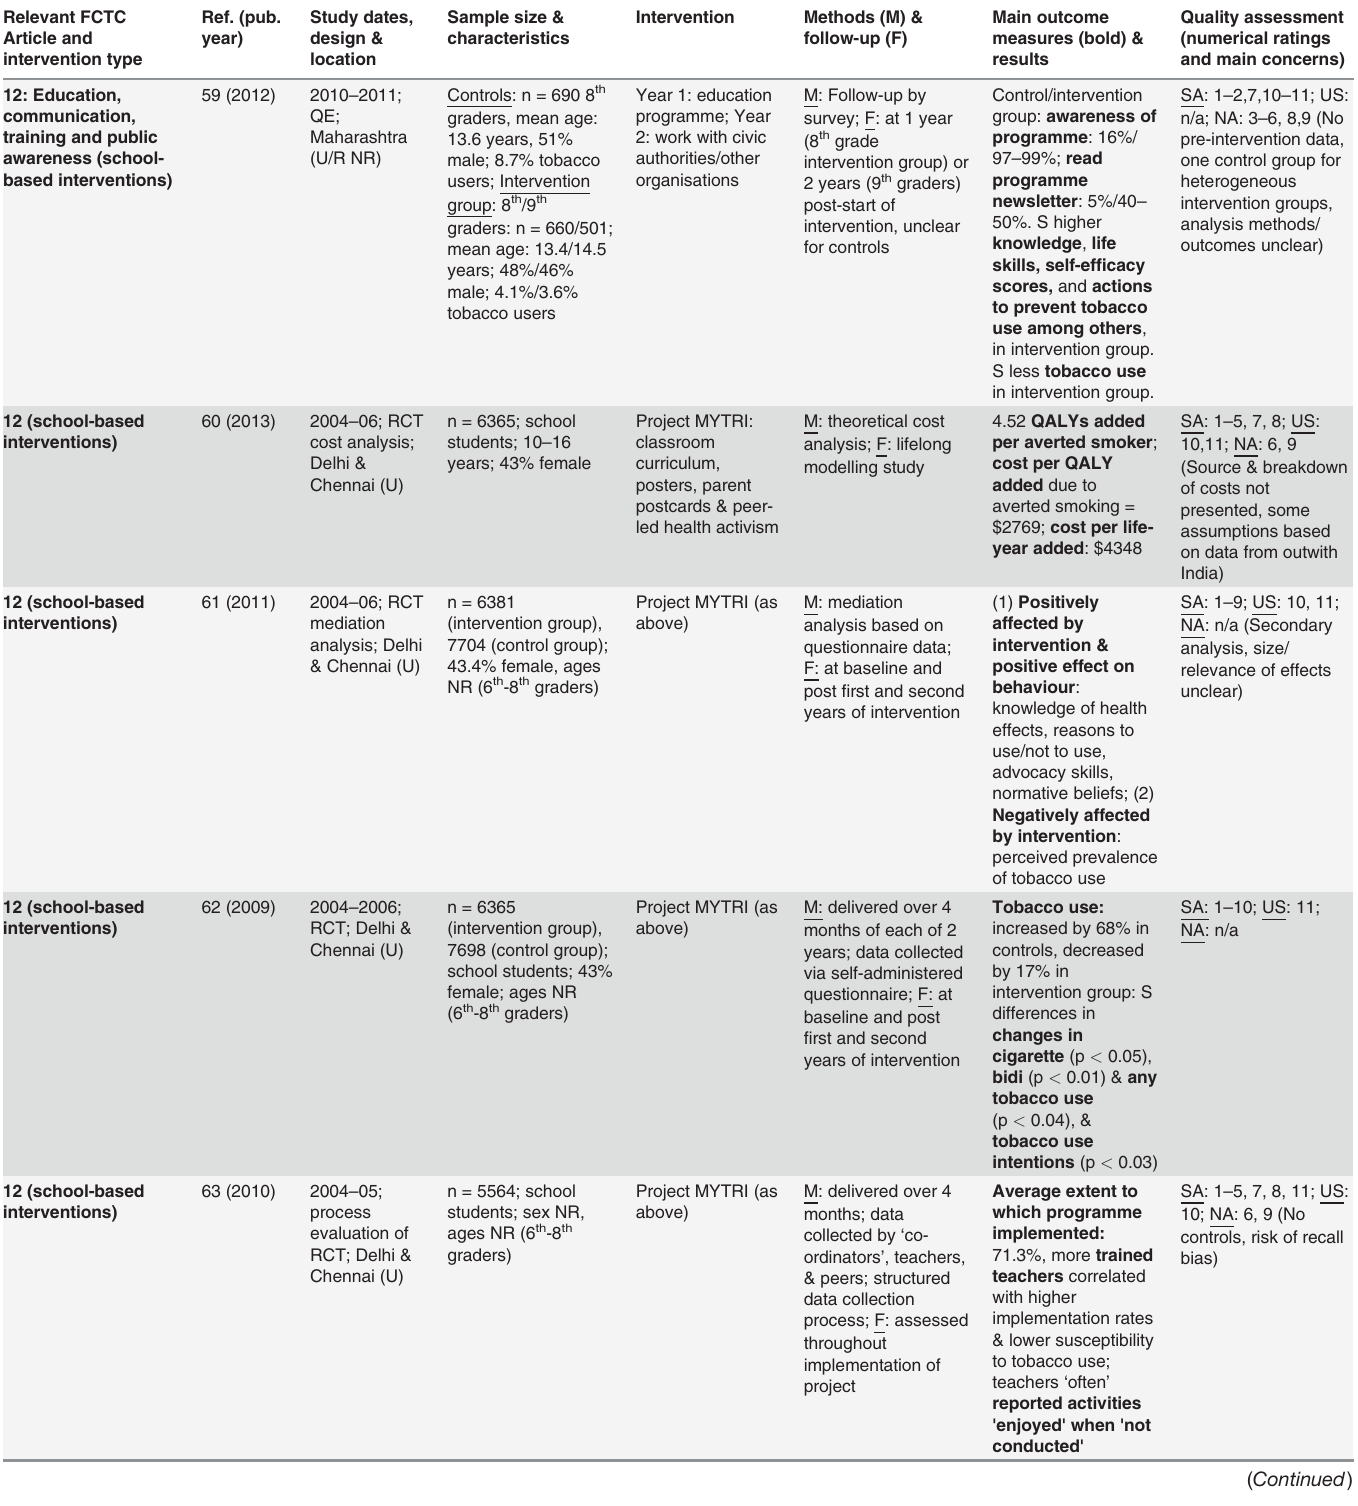
Table 7. Studies related to trialled